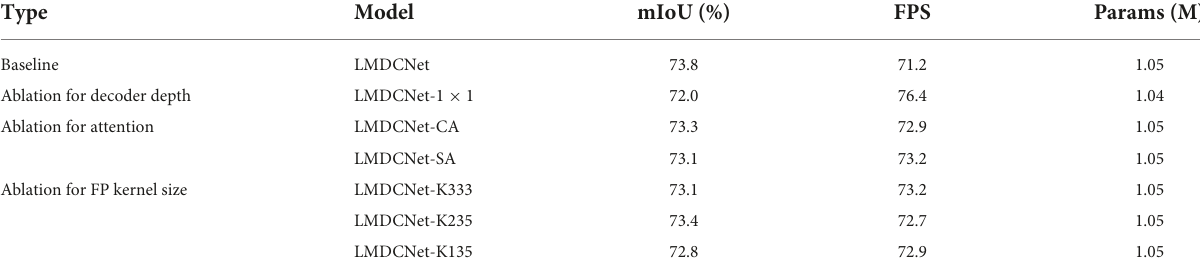
TABLE 3 Ablation study results of feature pyramid with spatial and channel attention (SC-FP module).